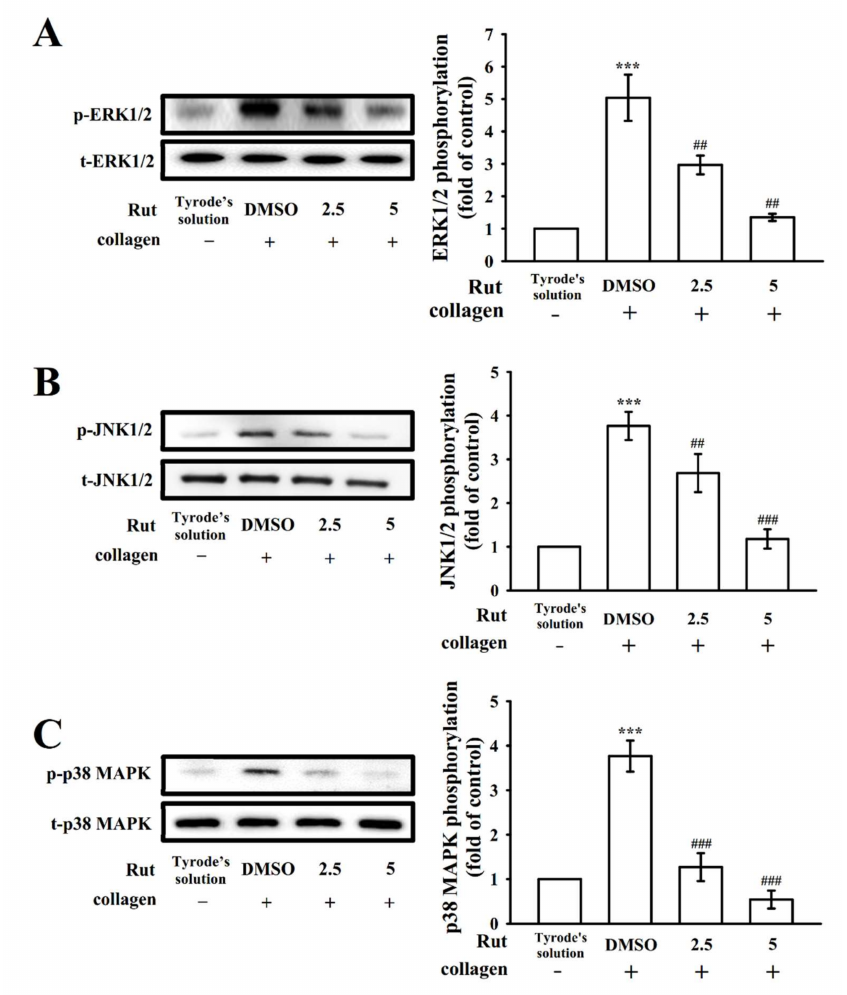
Figure 4. Regulatory characteristics of Rut on mitogen-activated protein kinase (MAPK) phospho- rylation in platelets. Washed platelets were preincubated with 0.1% DMSO or Rut (2.5 and 5 µ M) and then treated with collagen (1 µ g/mL) for immunoblotting ( A ) ERK1/2, ( B ) JNK1/2, and ( C ) p38 MAPK phosphorylation. Data are expressed as the mean ± standard error of the mean ( n = 4). *** p < 0.001 compared with the resting control; ## p < 0.01 and ### p < 0.001 compared with the 0.1% DMSO-treated